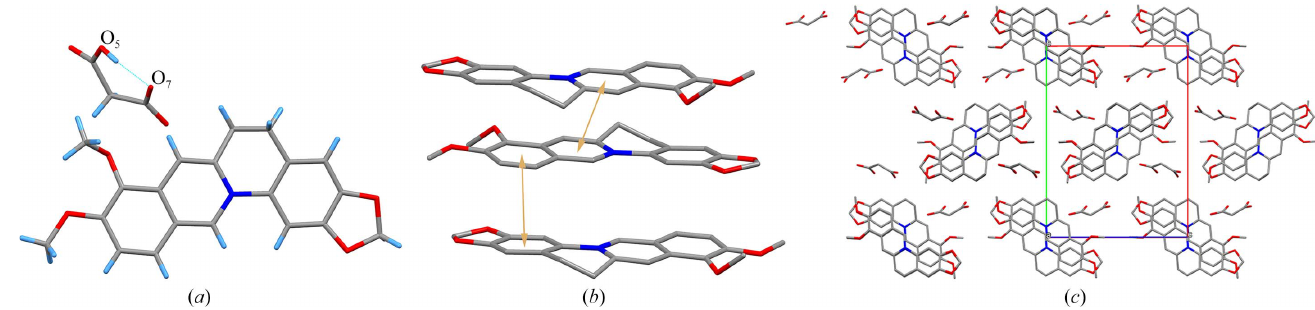
Figure 2 ( a ) Hydrogen bonds between molecules in 1BER-1MA. ( b ) (cid:9) – (cid:9) interactions between molecules in 1BER-1MA (hydrogen atoms have been omitted). ( c ) Three-dimensional structure of 1BER-1MA (hydrogen atoms have been omitted).